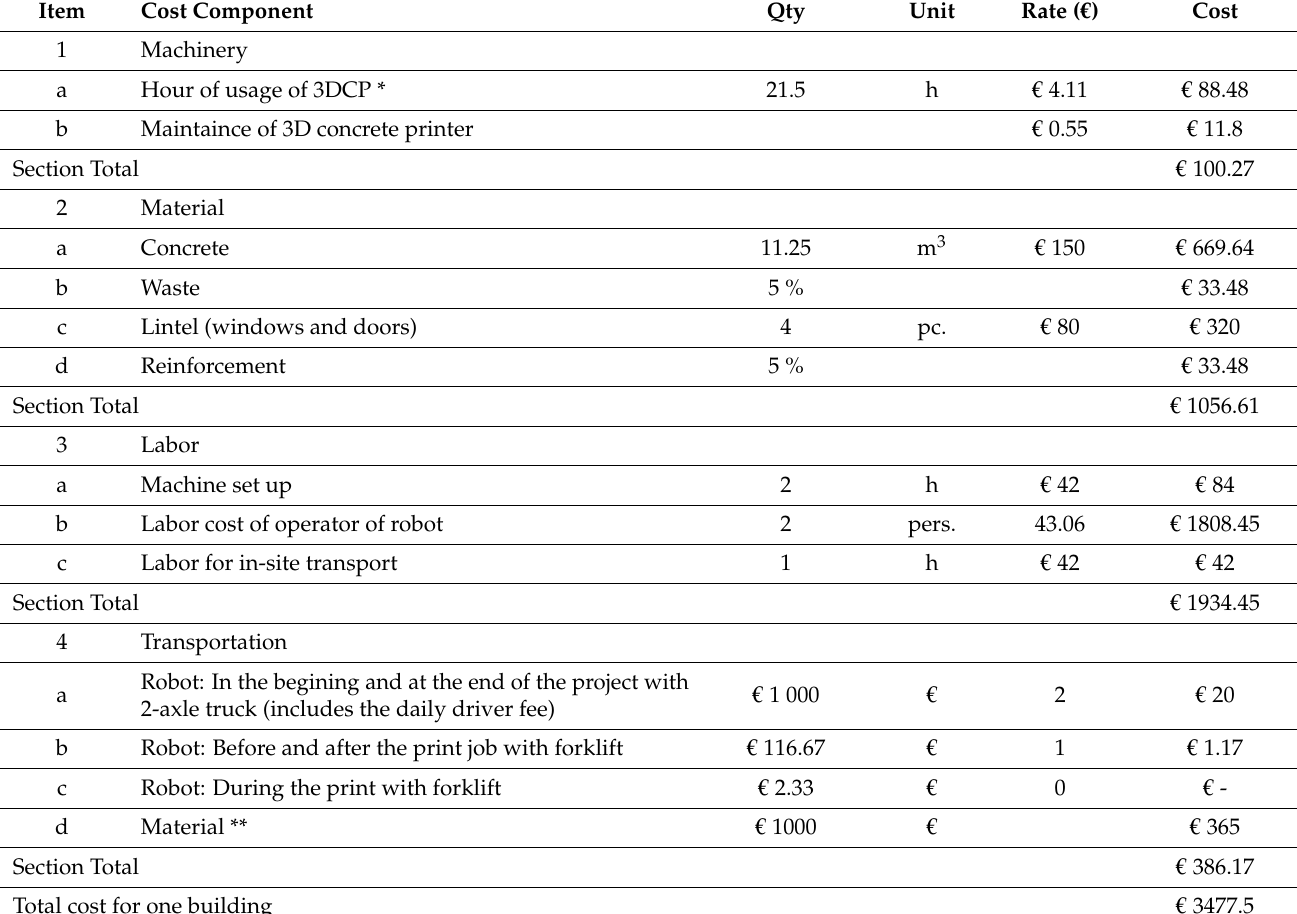
Table A2. Scenario 1 cost model in